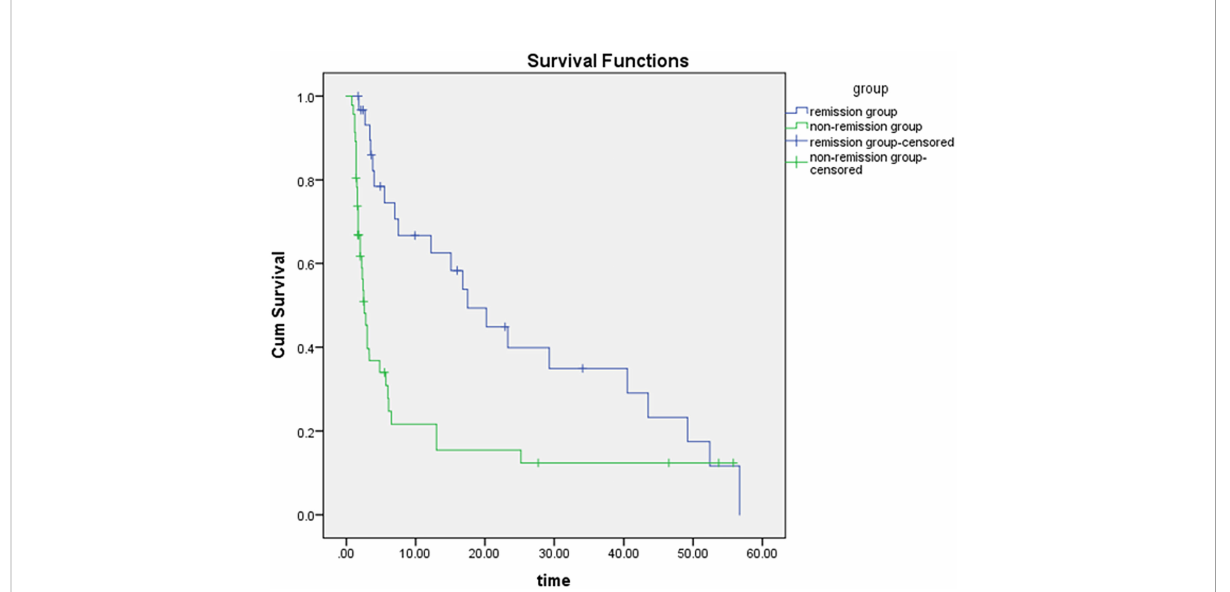
FIGURE 4 The difference in survival time between the two groups is statistically signi fi cant by the Kaplan-Meier method (p = 0.000), the dark blue curve is the survival curve of the remission group and the green curve is the survival curve of the non-remission